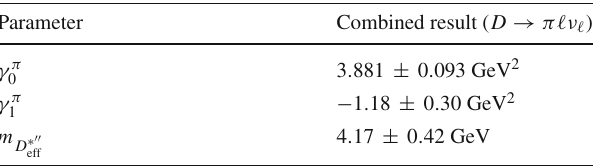
Table 279 Results of the three-pole model to BaBar , Belle, BES III and CLEO-c (tagged and untagged) data. Fitted parameters are the first two residues γ π and γ π , which are constrained using present measure- 0 1 ments of masses and widths of the D ∗ and D ∗ (cid:7) mesons, and lattice com- putations of decay constants, and the effective mass, m , accounting D ∗(cid:7)(cid:7) eff for higher mass hadronic contributions